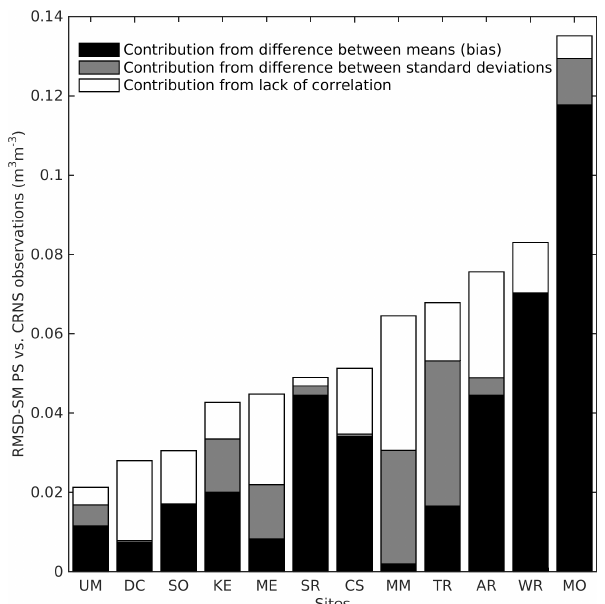
Figure 3. RMSD between observed PS and CRNS soil moisture (SM; m 3 m − 3 ) . MSD decomposition (Gupta et al., 2009) was cal- culated and the fractions were then applied to the RMSD values. Sites ranked from most similar to most different.